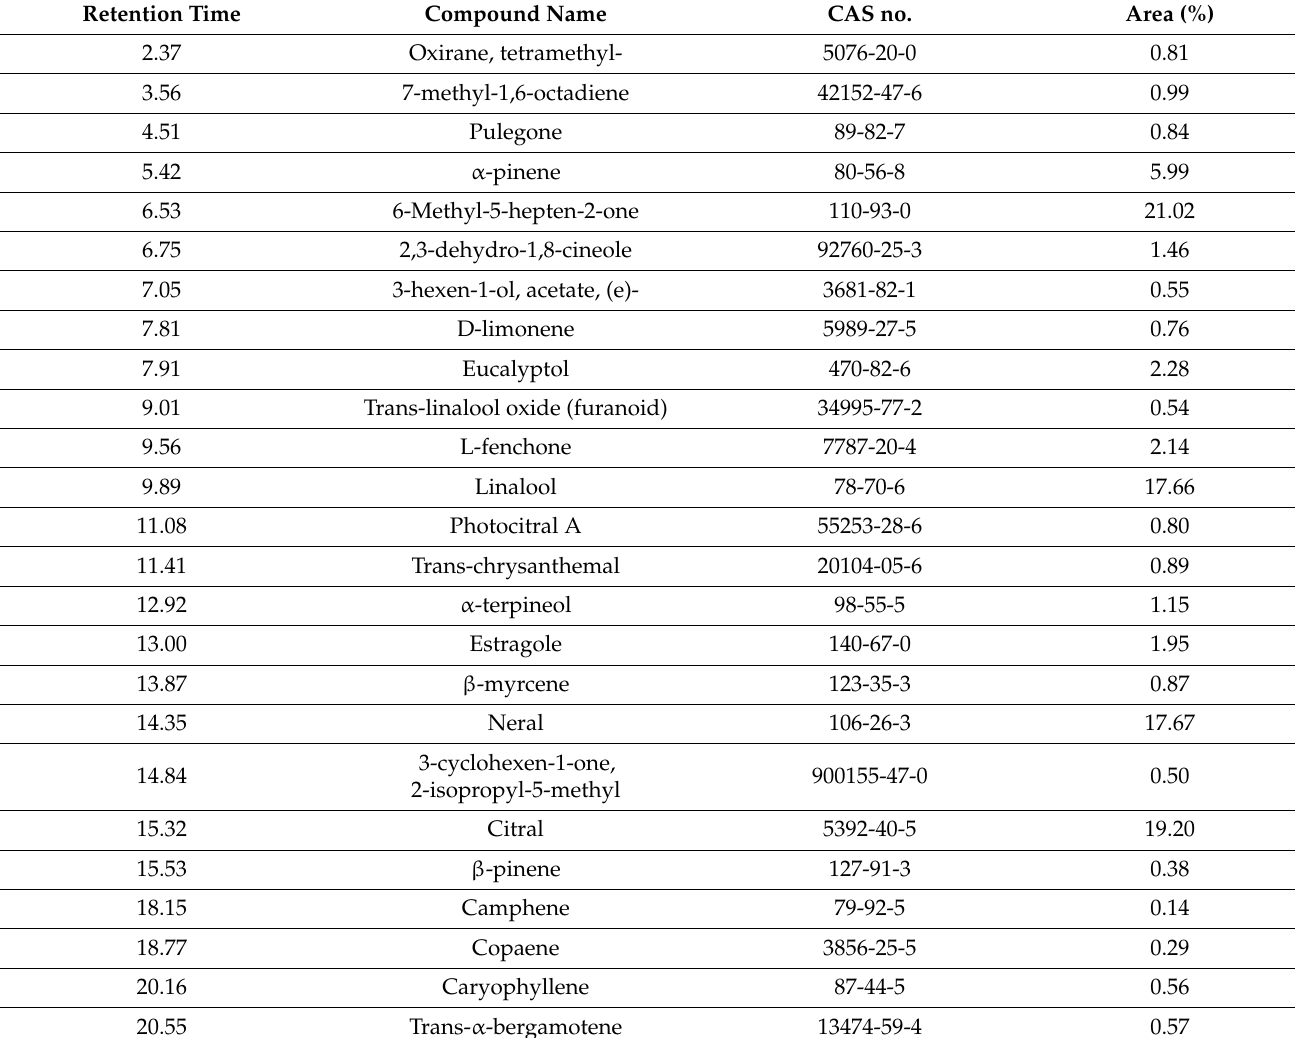
Table 3. Chemical constituents of the essential oil from O. x africanum , analyzed by